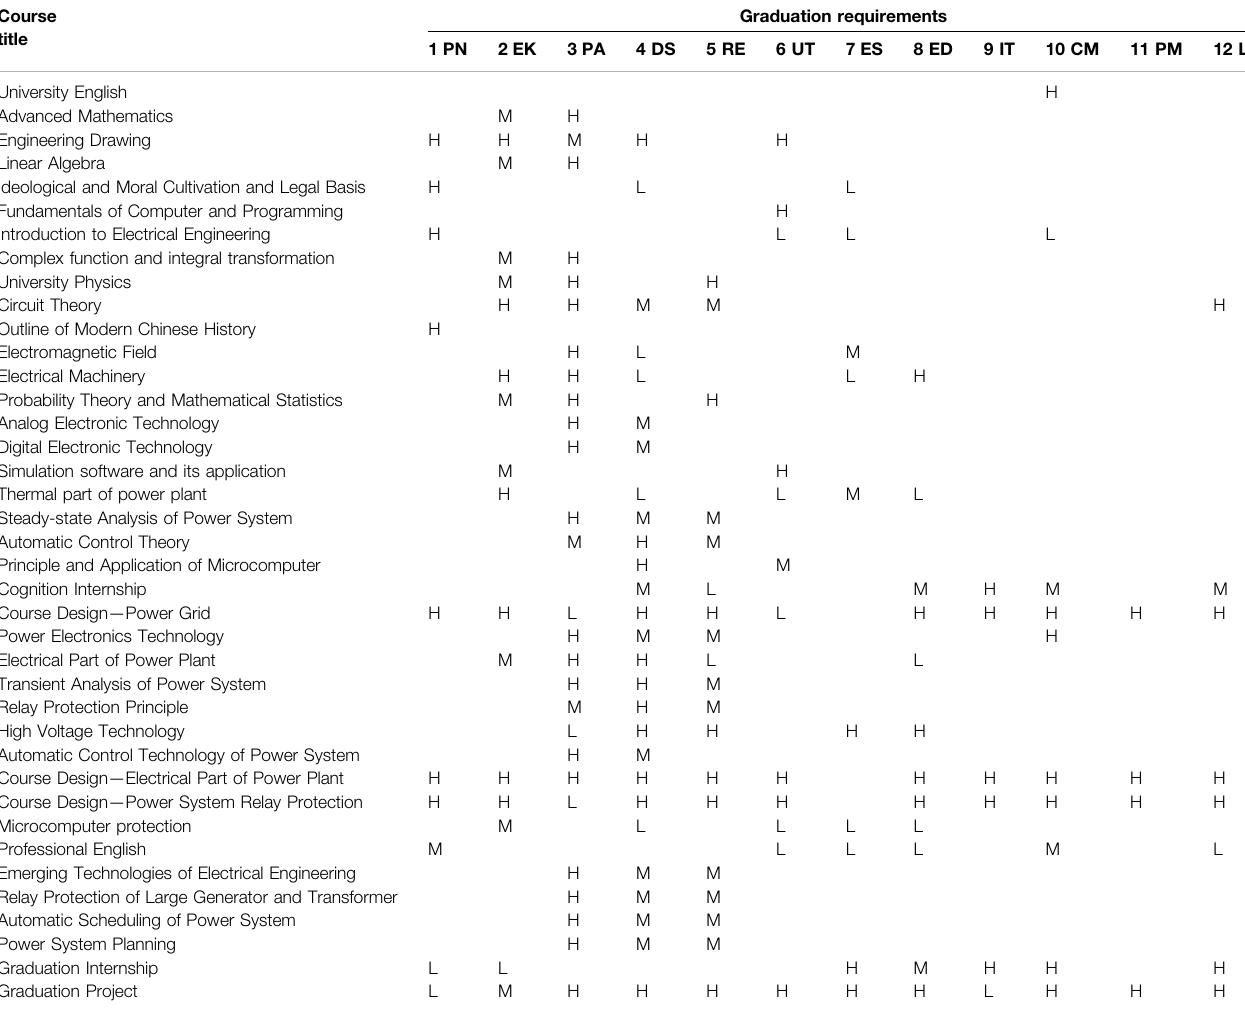
TABLE 5 | Correspondence matrix of courses and graduation requirements. Course